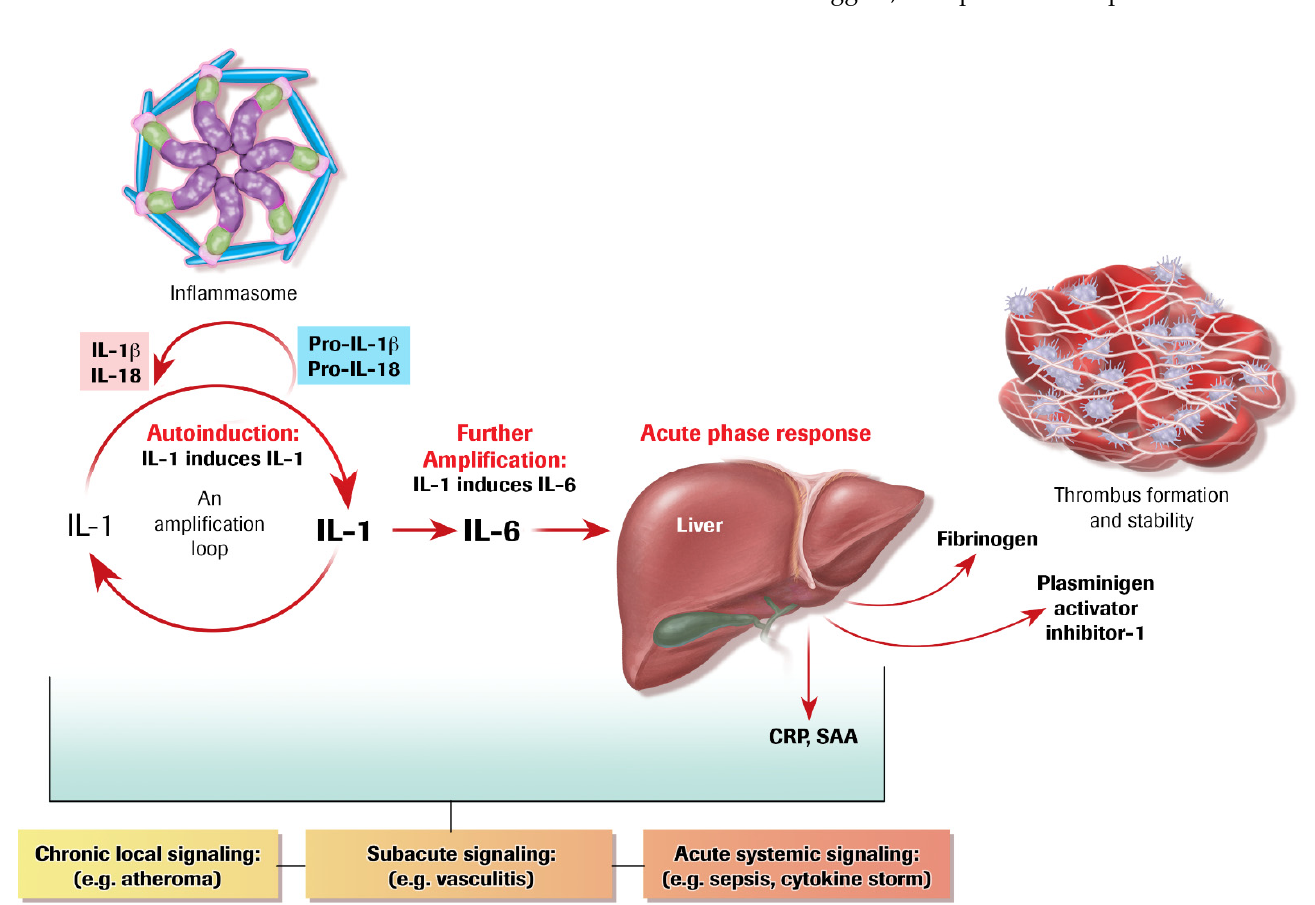
Figure 3. Amplification loops in cytokine signaling. IL-1 induces its own gene expression, auto-induction as shown on the left-hand of this figure. IL-1 can in turn induce IL-6 from many cell types, an amplification loop. IL-6 triggers the acute phase response in hepatocytes which augments fibrinogen, the precursor of clots, and plasminogen activator inhibitor-1 (PAI-1), proteins that favor clot formation and resist fibrinolysis. The acute phase reactants C-reactive protein (CRP) and serum amyloid A (SAA) can serve as biomarkers of the inflammatory response. The inflammasome can process the inactive forms of IL-1 β and IL-18 to their biologically mature forms instigating this inflammatory cytokine cascade. This series of amplification steps can occur locally in a chronic disease such as atherosclerosis, more acutely locally in many diseases including the vasculitides. The positive feedback loop can lead to cytokine storm associated with sepsis or acute viral infections such as SARS-CoV-2.